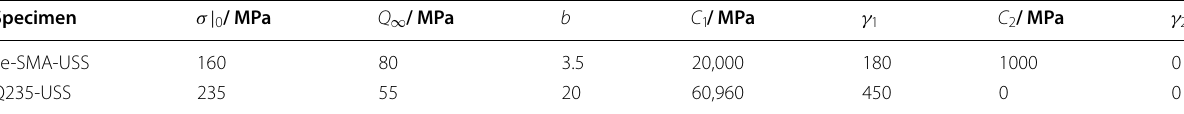
Table 4 Calibrated cyclic constitutive parameters for simulating USS specimens on ABAQUS Specimen σ | 0 / MPa Q ∞ / MPa